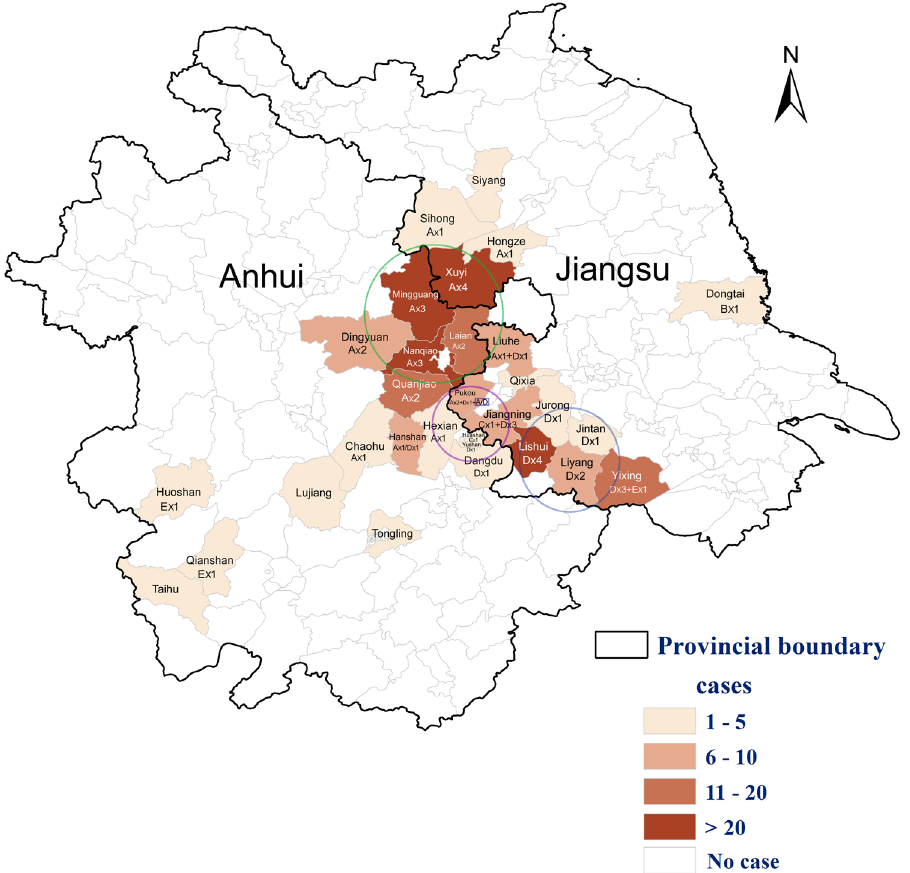
Figure 3. The geographical distribution of SFTS cases and SFTSV genotypes in Jiangsu and Anhui provinces. This map was created using the software ArcGIS version 10.0 (http://www.esri.com/). A, C, D, and E represented genotype A, C, D, and E of SFTSV strains distributed in each county of the SFTS endemic areas; A/D represented reassortment between SFTSV genotype A and genotype D; The green, purple and blue circles represented northern, central and southern part of the endemic areas in study,